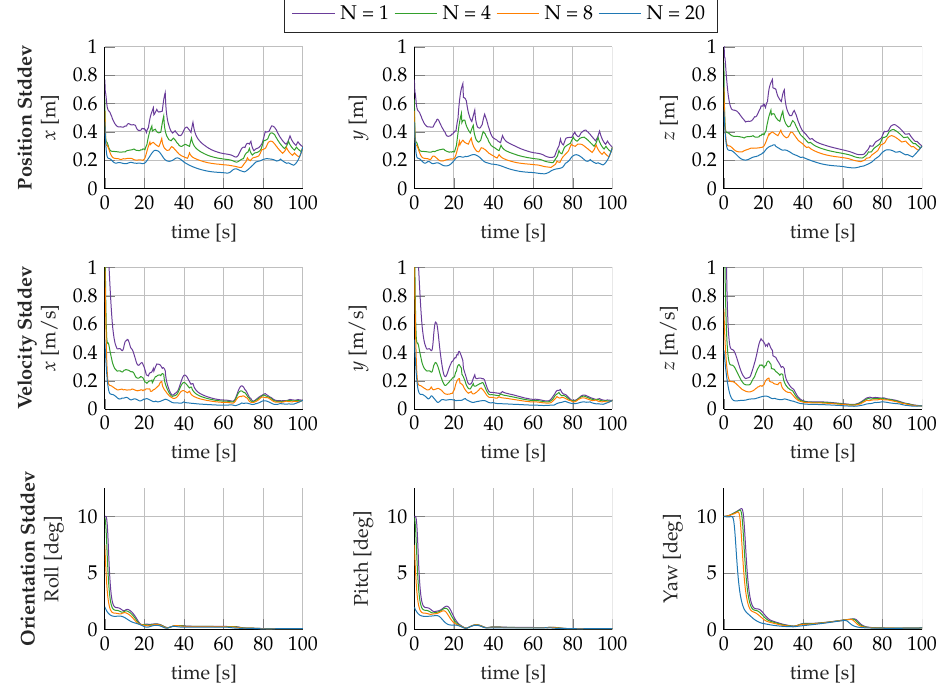
Figure 7. Evolution of standard deviations of the time-lagged estimate of the navigation states: position, velocity, and orientation with increasing horizons N